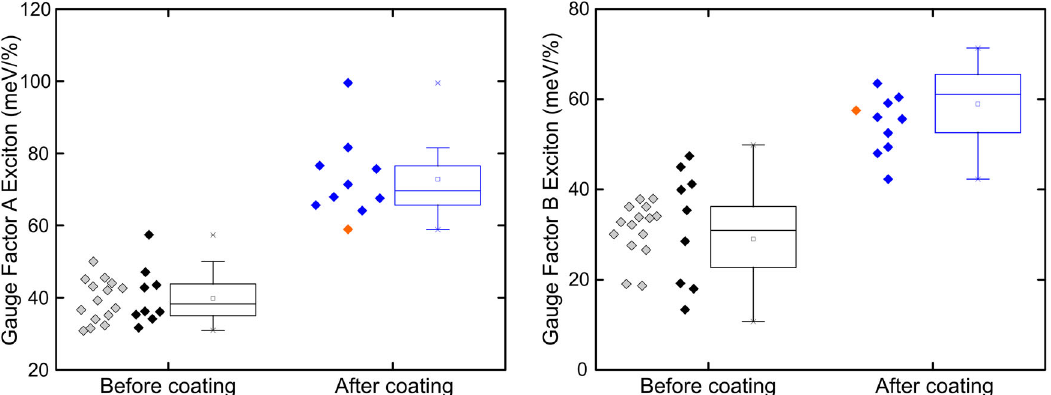
Fig. 3 Statistical fl ake-to- fl ake variation of the gauge factor. Statistical fl ake-to- fl ake variation before encapsulation (black and grey dots) and after encapsulation (blue dots). Grey dots correspond to other 15 un-encapsulated samples that were measured in our previous work 11 . Orange dots refer to the same sample that was tested in Fig. 2 after being subjected to several reproducibility cycles and testing it till the device failure.